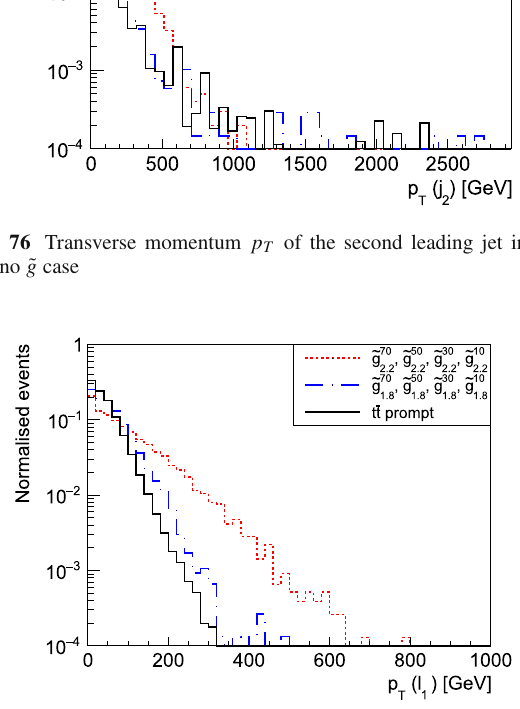
Fig. 77 Transverse momentum p T of the leading lepton in the gluino ˜ g case